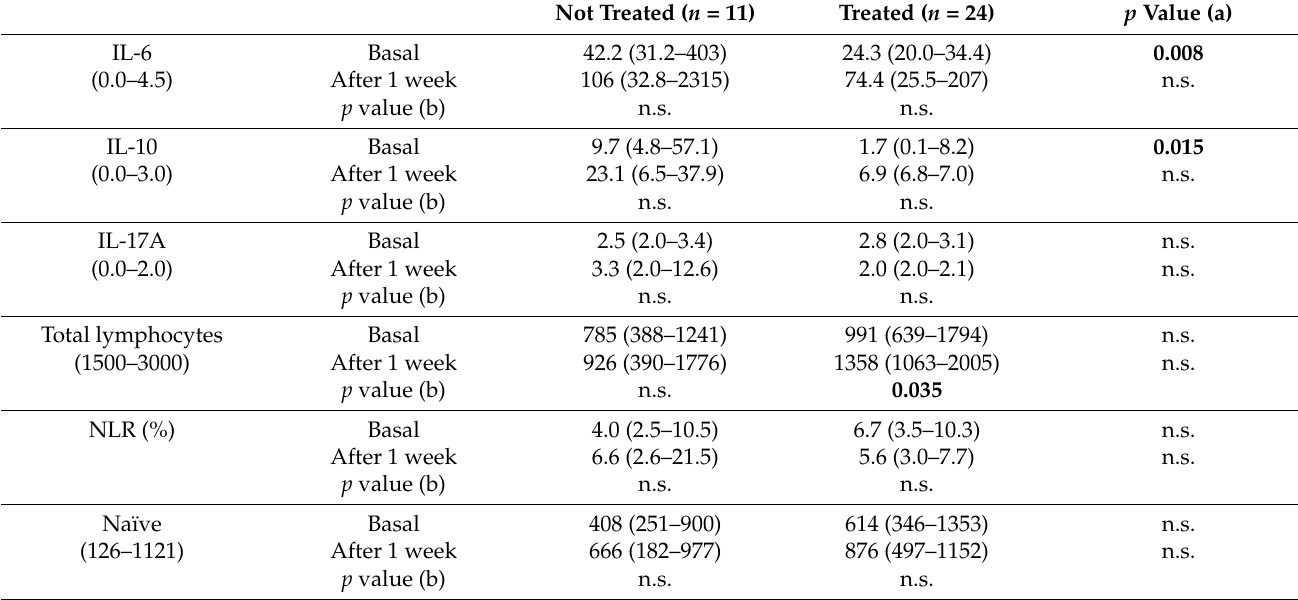
ences were observed in untreated patients.